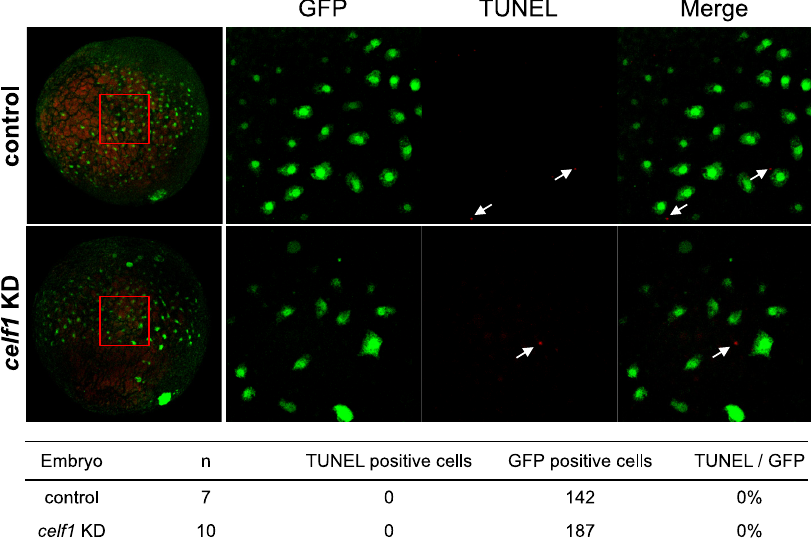
Figure A2. Cell death in zebrafish embryos at 90% epiboly stage. TUNEL assays were performed in Tg [ sox17:GFP ] embryos at 9 hpf. Green and red signals indicated GFP-expressing endoderm cells and TUNEL positive cells, respectively. Arrows marked TUNEL positive cells. Right panels were higher magnification images highlighting endoderm cells with the embryo ( left panel ). TUNEL signals were detected within the embryos, but we could not find TUNEL positive endoderm cells in control and celf1 KD embryos.